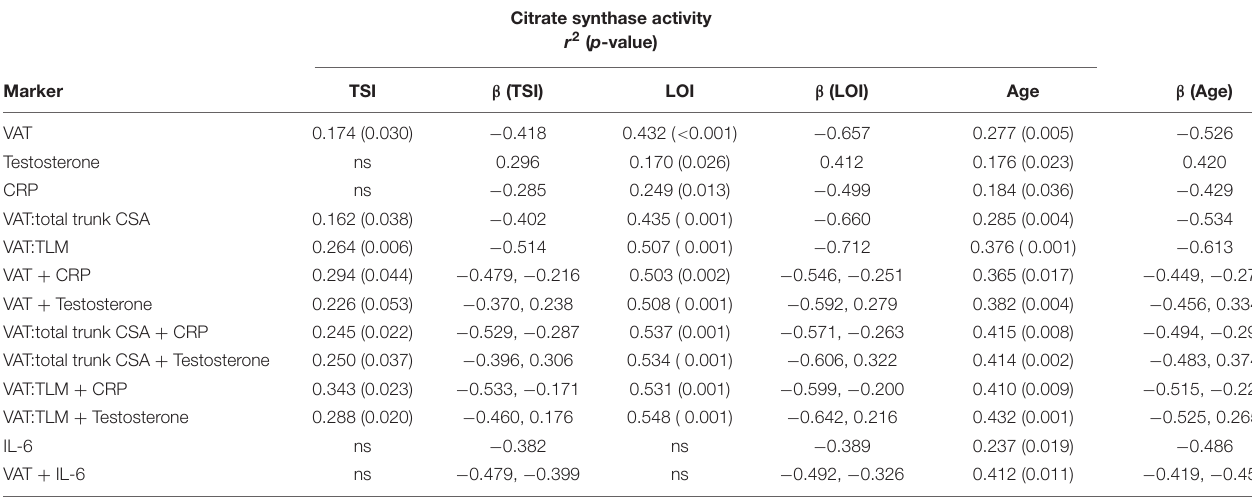
TABLE 4 | Single and multiple regressions predicting Citrate Synthase activity after controlling for TSI, LOI, or age.